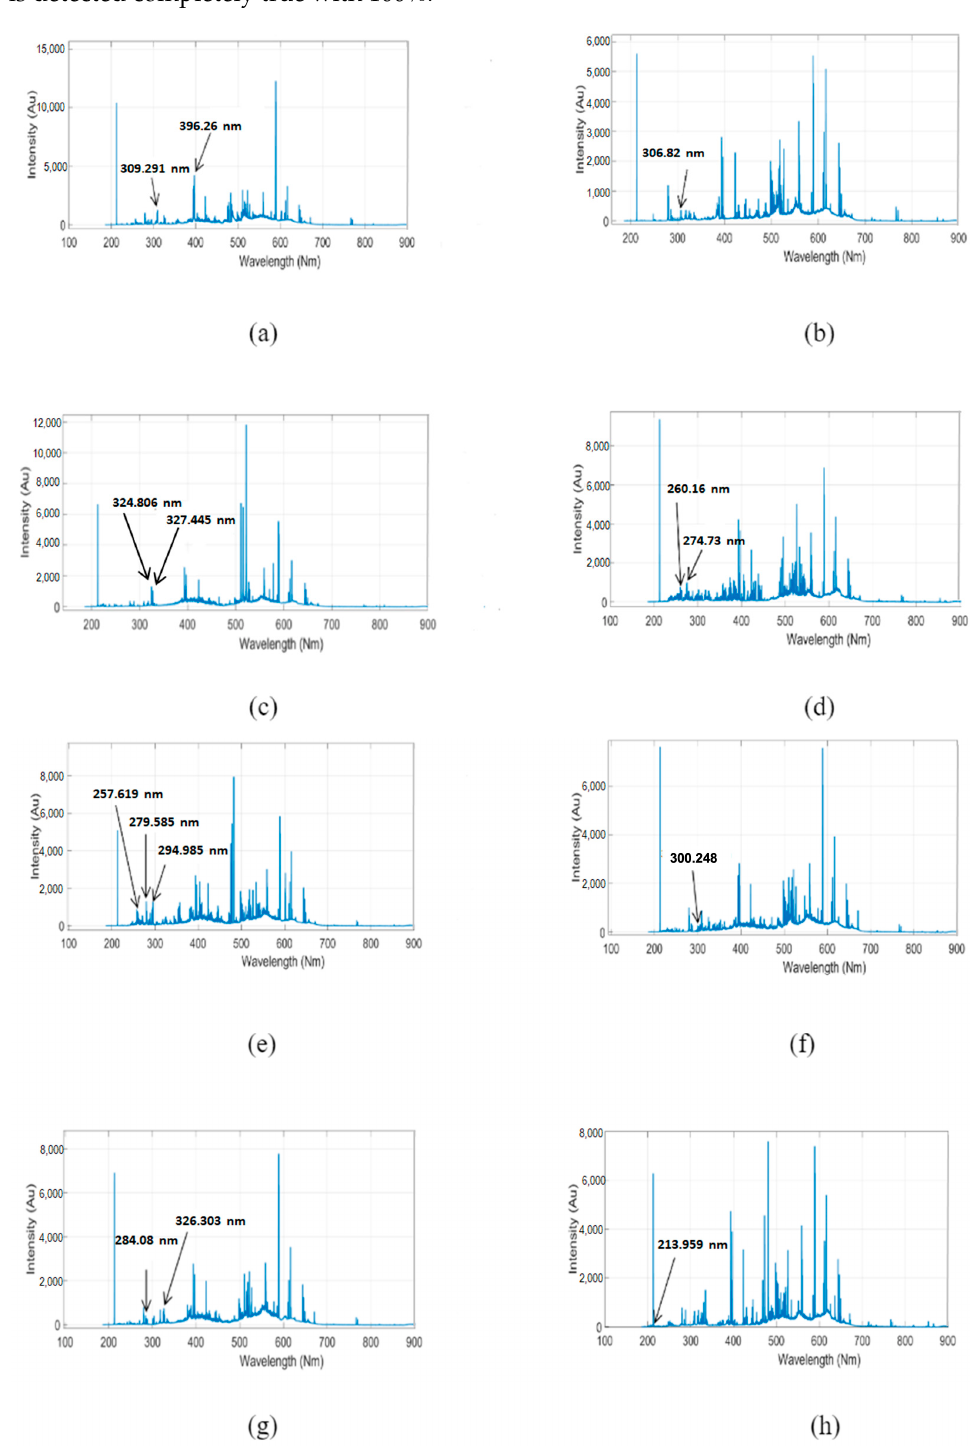
Figure 4. Detected substances of LIBS data obtained from measurement; ( a ) Al, ( b ) Bi, ( c ) Cu, ( d ) Fe, ( e ) Mn, ( f ) Ni, ( g ) Sn, ( h ) Zn.